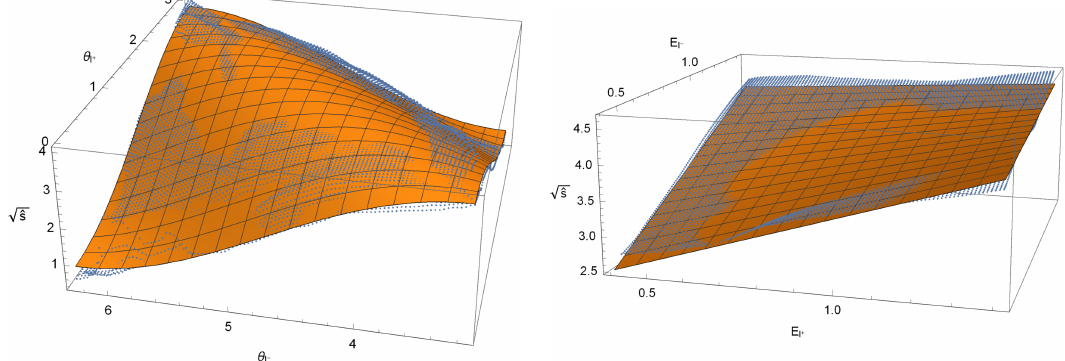
Figure 8 . The relationship between ˆ s and the 4-momenta of charged leptons in eqs. (5.1) and (5.2) given by the ANN (the dots). The left panel is for eq. (5.1) and the right panel is for eq. (5.2). The curved surfaces are functions fitted by using the anstaz a 1 + a 2 cos( θ